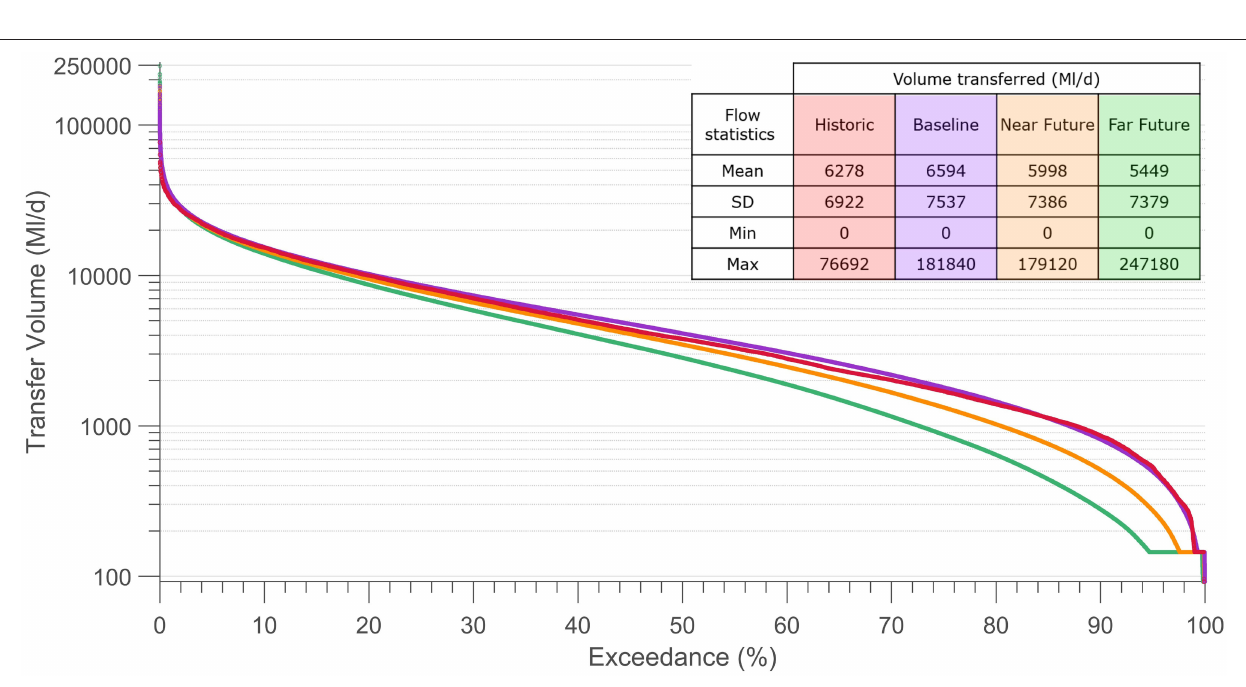
FIGURE 7 | Exceedance curves and statistics for volume of transferred water under Unlim.R.U. for each flow ensemble (Historic—red, Baseline—purple, Near Future—orange, Far